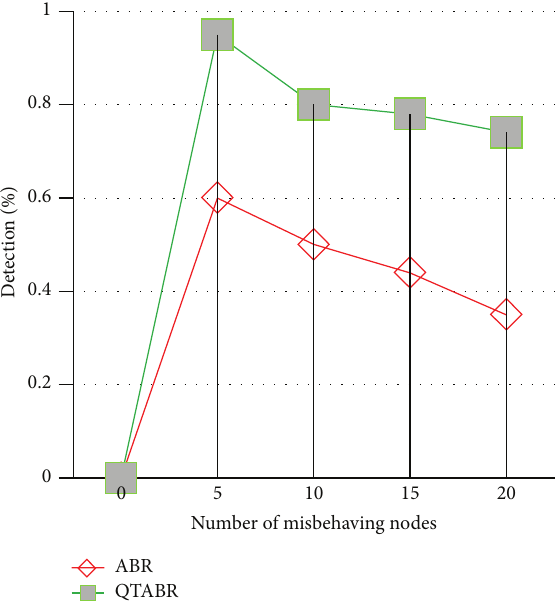
Figure 12: Percentage of detection of malicious